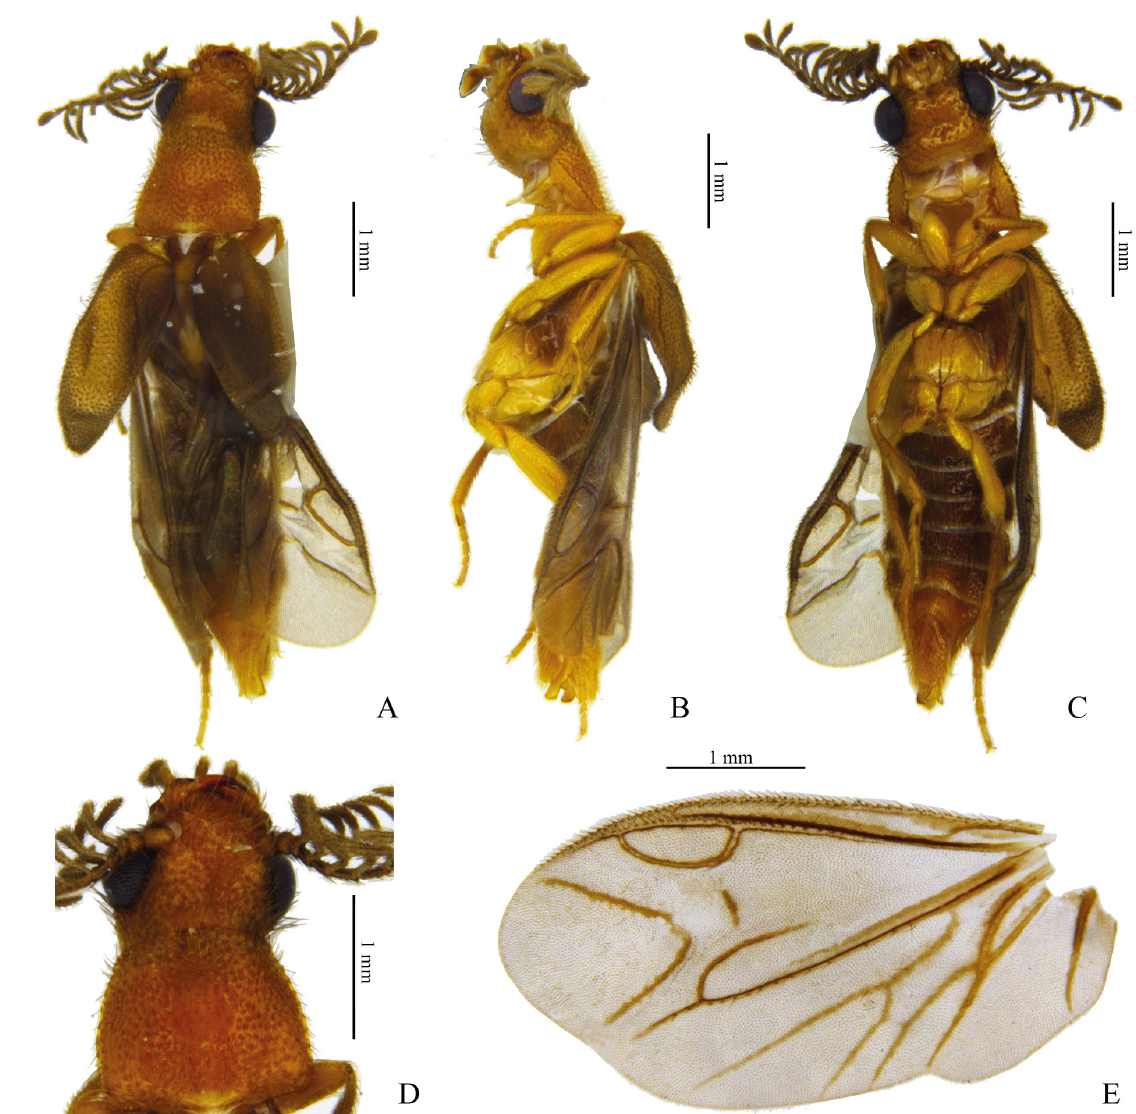
Fig. 1. Iviephengus ferreirai gen. et sp. nov. A–D . Holotype, ♂ (MUSM). A . Habitus, dorsal. B . Habitus, lateral. C . Habitus, ventral. D . Head and pronotum, lateral. E . Paratype, ♂ (DZRJ). Posterior wing,